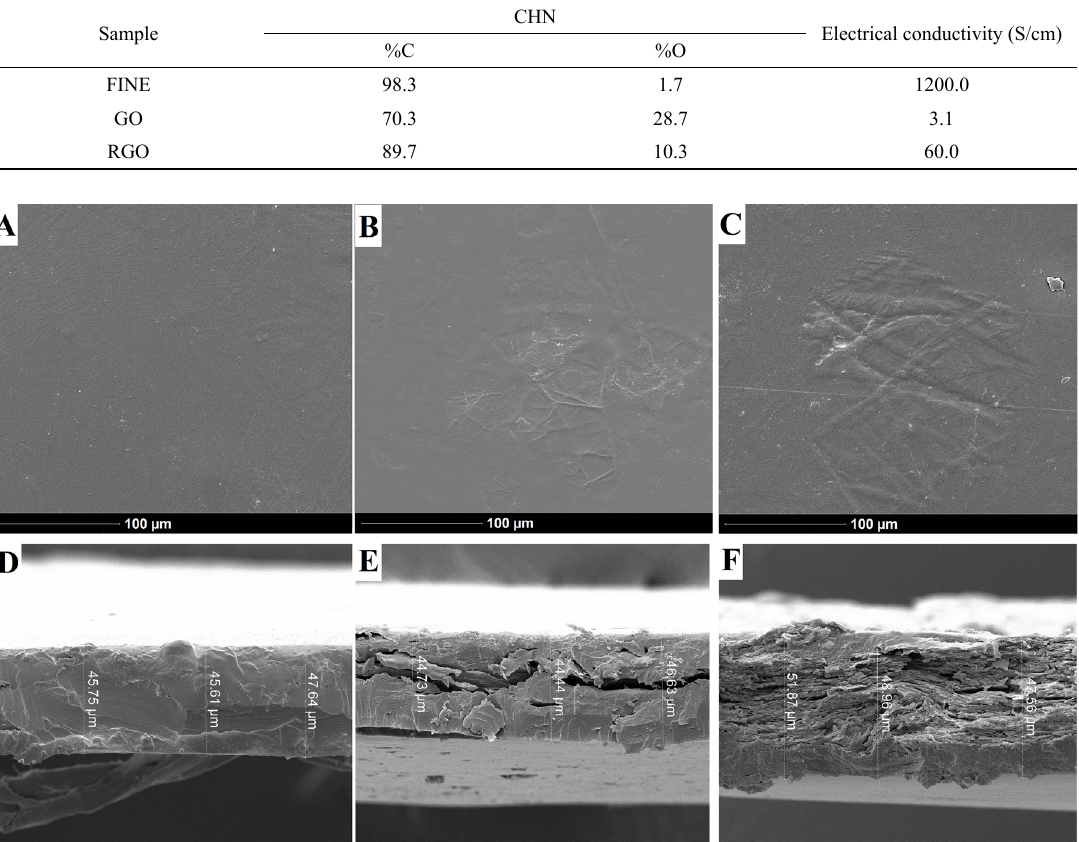
Table 2. Elemental analysis and electrical conductivity for FINE, GO and RGO.